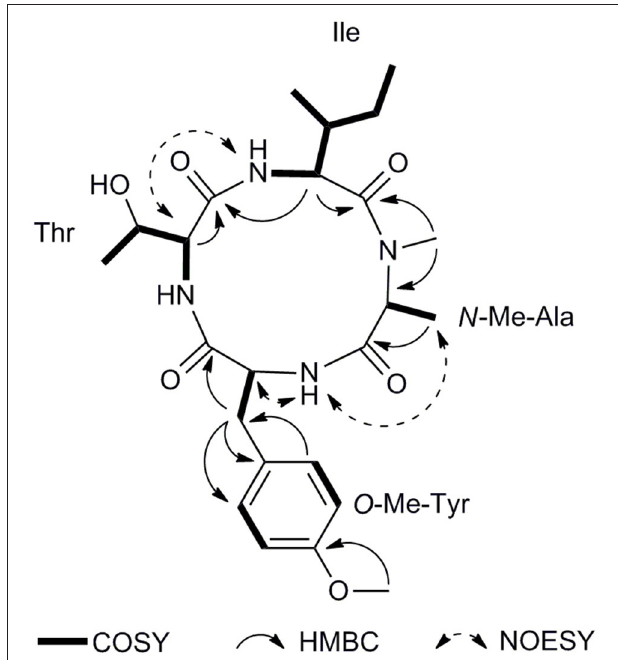
FIGURE 2 | Key COSY, HMBC, and NOESY correlations of 1 .